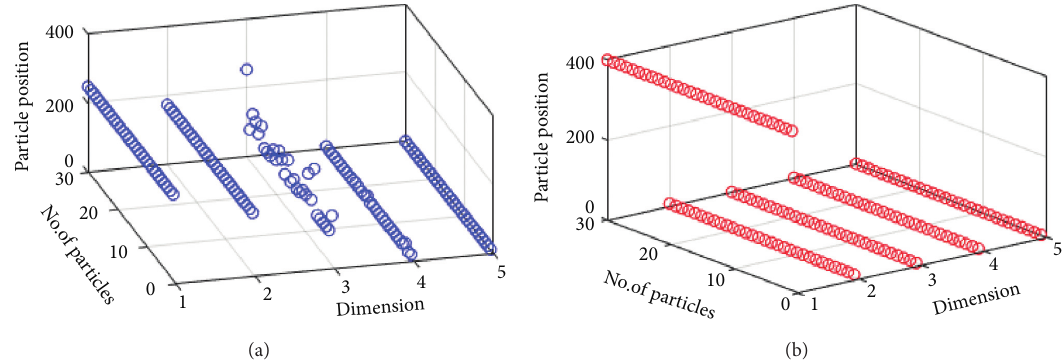
Figure 12: Particle convergence after 200 iterations. (a) PSO. (b) AIWPSO.